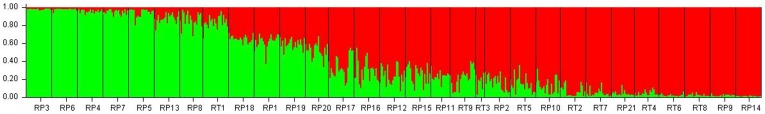
Genetic relationships among the 30 populations of R. palmatum and R. tanguticum (574 individuals) estimated using STRUCTURE program based on ISSR data.The model with K = 2 showed the highest ΔK value.